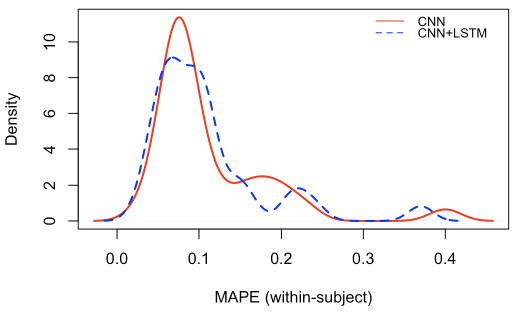
Figure 9. Density plot of the Mean Absolute Percentage Errors (MAPE) of the test data of the 32 within-subject models, respectively, trained only with the single Convolutional Neural Network (CNN), and the Convolutional/Recurrent Neural network (CNN+LSTM). The comparisons of Figure 10 highlight a number of things. Firstly, the main bursts in the brain rates are also grasped by the CNN and the CNN+LSTM models. However, those associated with the CNN (red) are shifted a bit to the right (x time axis) when compared to those associated with the CNN+LSTM (blue), which seem to be more aligned to the brain rates (green) over time. This is confirmed by the Person correlation coefficient, which on average for participants and testing videos, is 0.5 for the CNN models and 0.7 for the CNN+LSTM models. This means that the LSTM layer in the CNN+LSTM architecture did learn some temporal relationships and long/short-term dependencies. The CNN+LSTM predictions are smoother than those produced by the single CNN, and this might be justified by the fact that they are based on the information taken from the precedent 7 consecutive EEG windows over time. For the same reasons, this might be the reason why the scale (y-axis) of the predictions of the CNN+LSTM (blue) is a bit lower than the others (blue and green).